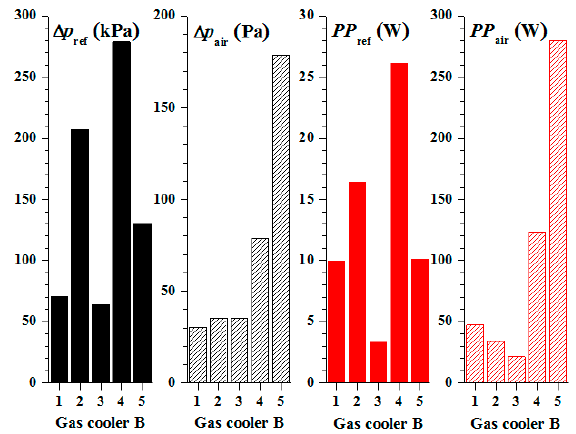
Figure 17. Comparison between 8 mm and 5 mm coils gas cooler A for Δ p ref , Δ p air , PP ref , and PP air .